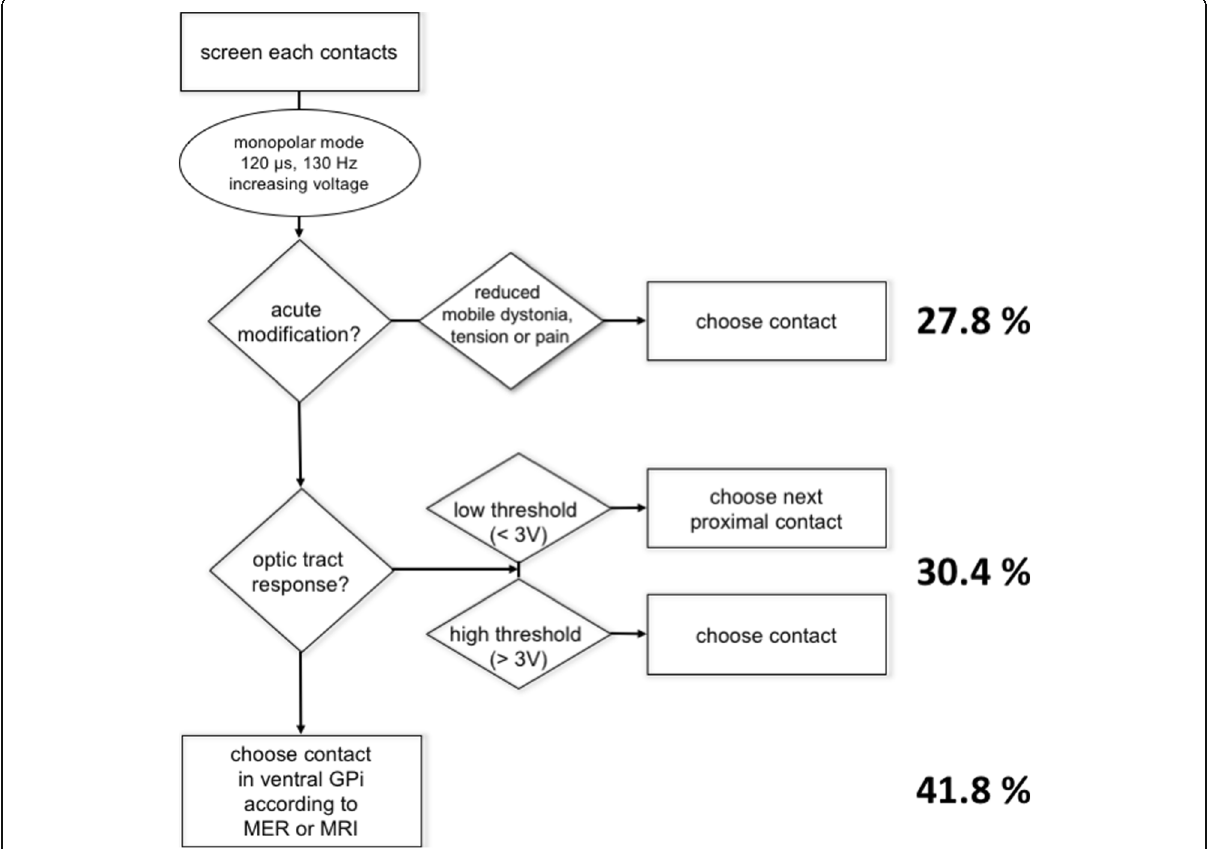
Fig. 1 Flow chart describing the basic procedure of the original study protocol for configuring the device during the monopolar review session. Numbers depicted on the right give the percentage of electrode contacts chosen using this criterion at the beginning of our